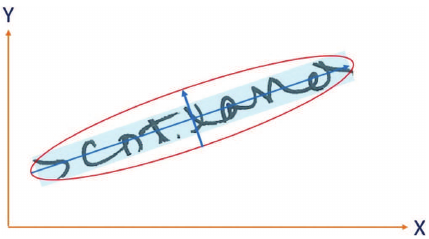
Figure 6: Approximate Core Region ( P ′ ) and Best-Fitting Ellipse.